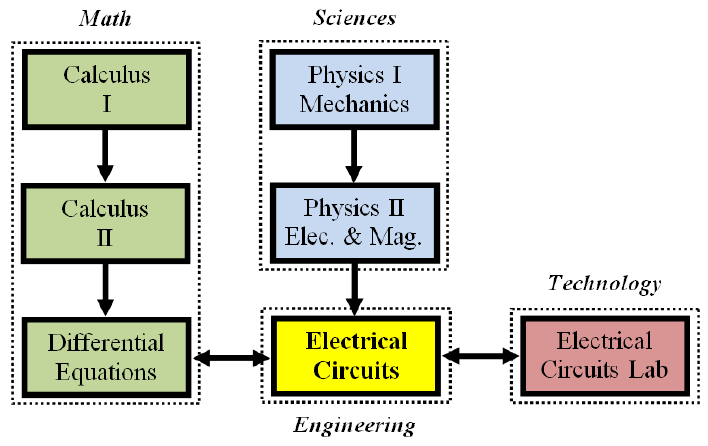
Fig. 1. Layout of a STEM-based structure for a sample course